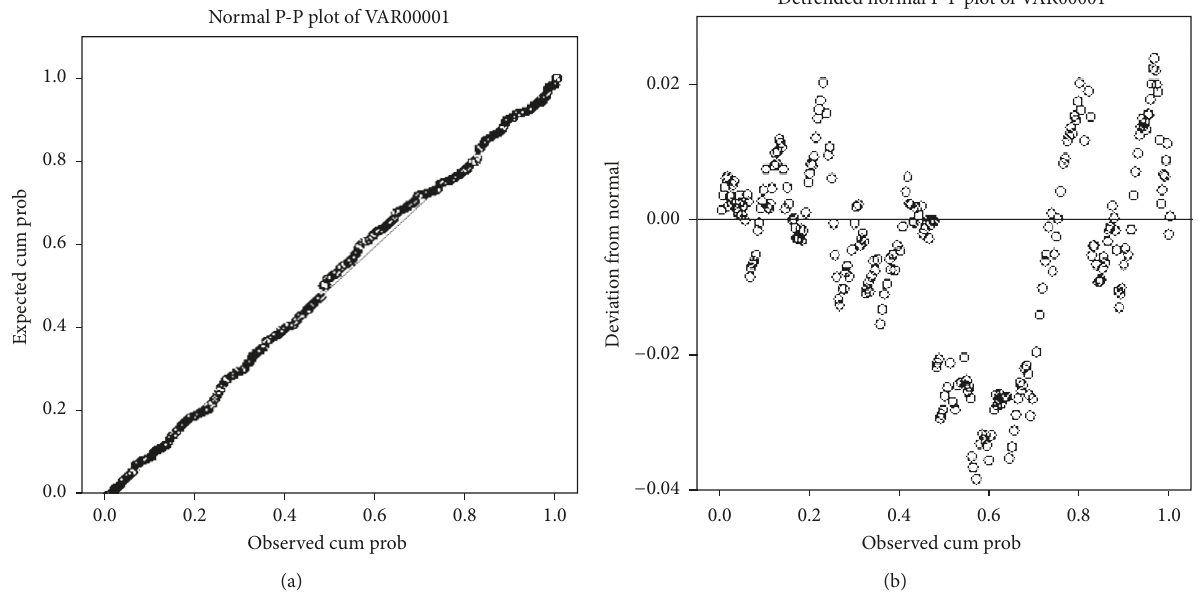
Figure 1: Normal probability plot of cars. (a) Cumulative probability distribution. (b) Deviation from